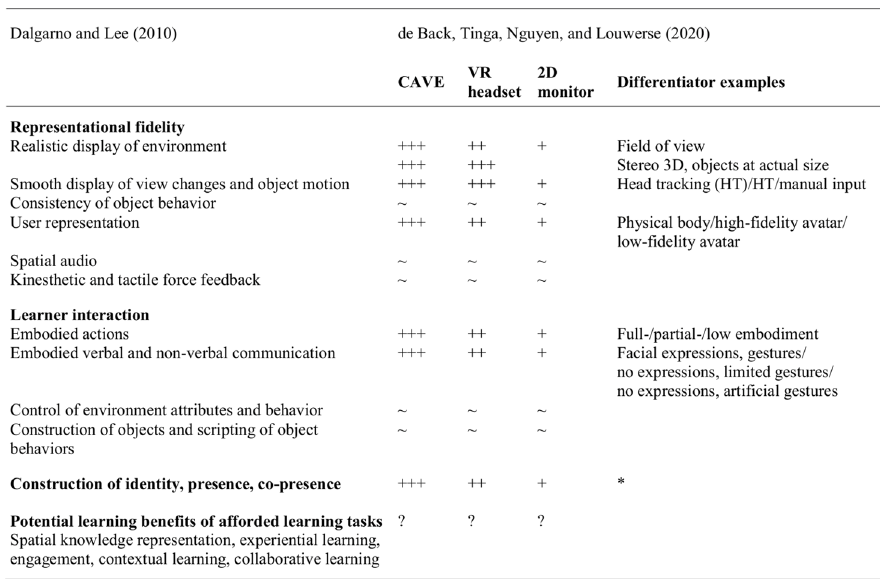
Table 1 Characteristics of virtual learning environments with examples of technical differentiators of CAVEs, VR headsets and 2D monitors, and potential learning benefits of afforded learning